Question: What kind of plot is shown here?
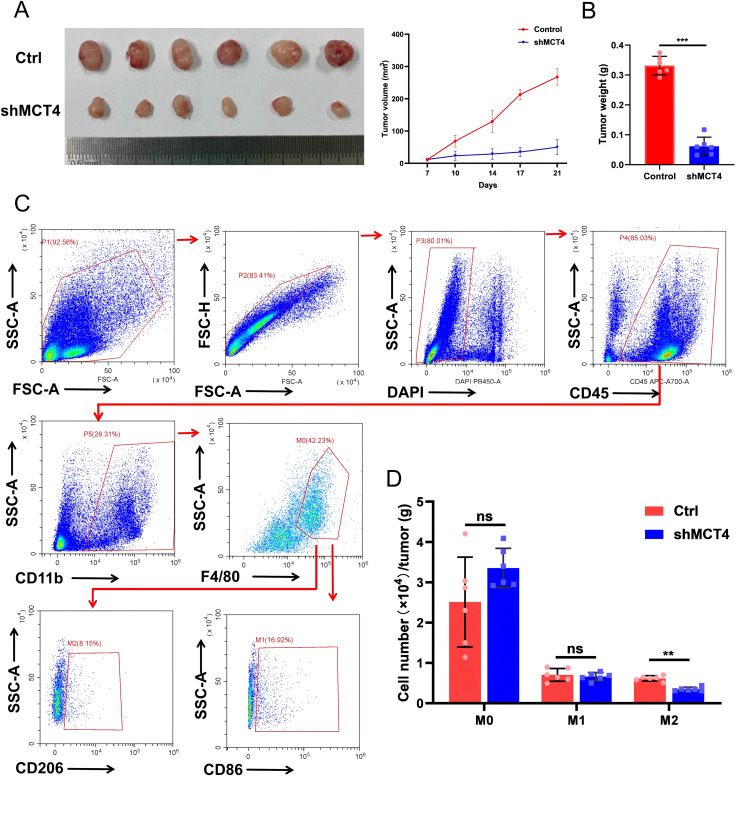
Answer: line